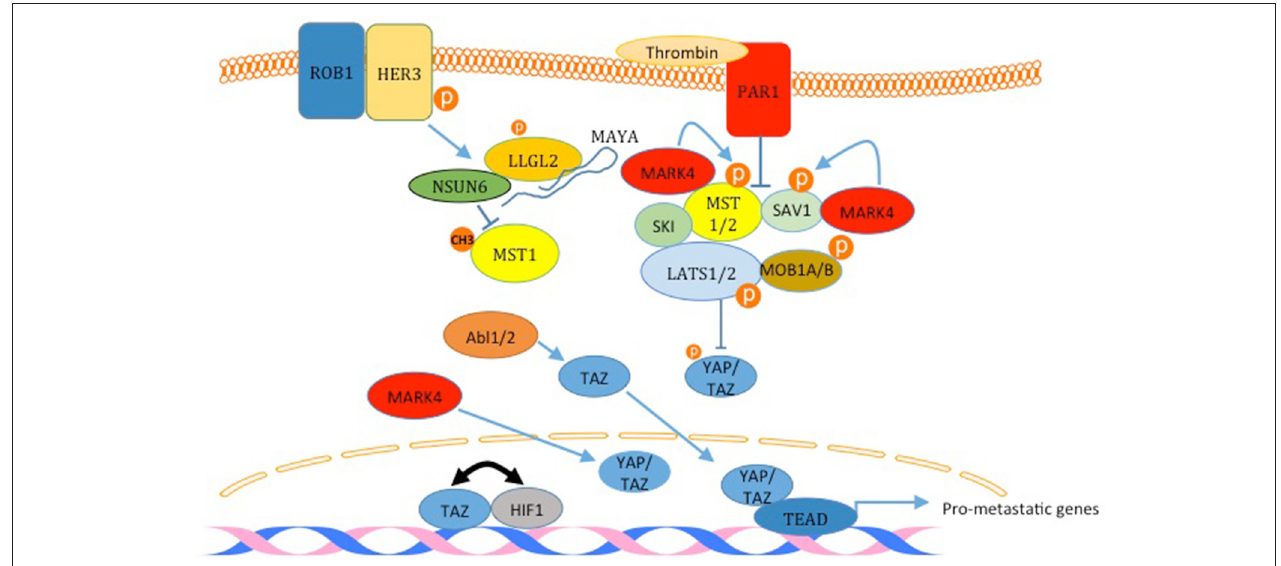
FIGURE 4 | Inactivation of the Hippo pathway induces breast cancer metastasis. The factors labeled in red are examples of proteins that inactivates the Hippo pathway and induces metastasis. PAR1 activation and the kinase MARK4 destabilize the core complex and inhibits its activity. MARK4 can increase nuclear YAP and TAZ too. The activation of HER3 by ROB1 leads to the assembly of a complex between MAYA ncLRNA, LLGL2 and the methyl transferase NSUN6 that methylates and inactivates MST1. Abl kinases can also increase nuclear TAZ. Finally, TAZ and HIF1 and reciprocally act as transcription co activators for each other. The only Hippo pathway activator shown here is SKI which binds LATS2 and MST1 and strengthen the core complex.